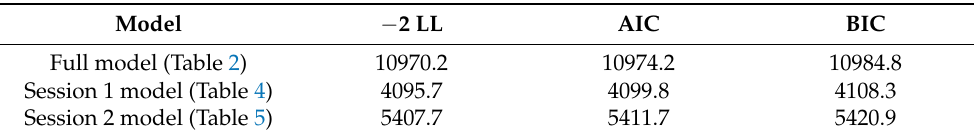
Table 4. Performance of the